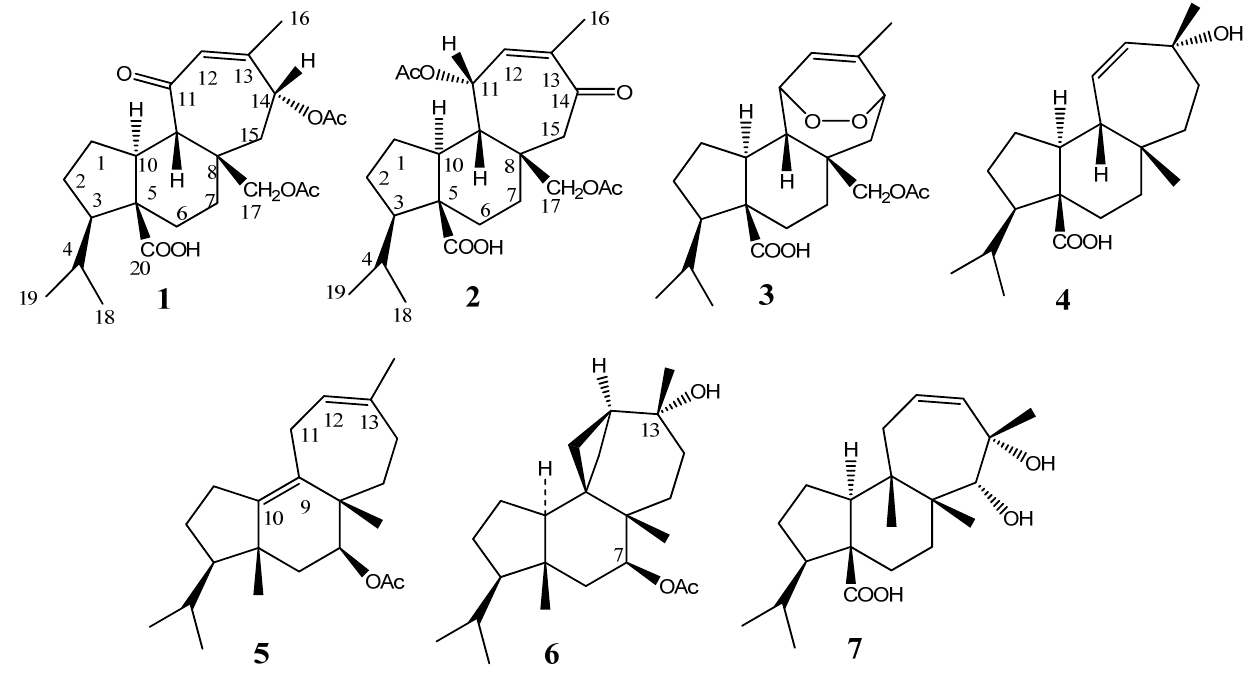
Figure 2. Structures of the diterpenoids isolated from Mulinum crassifolium and Azorella